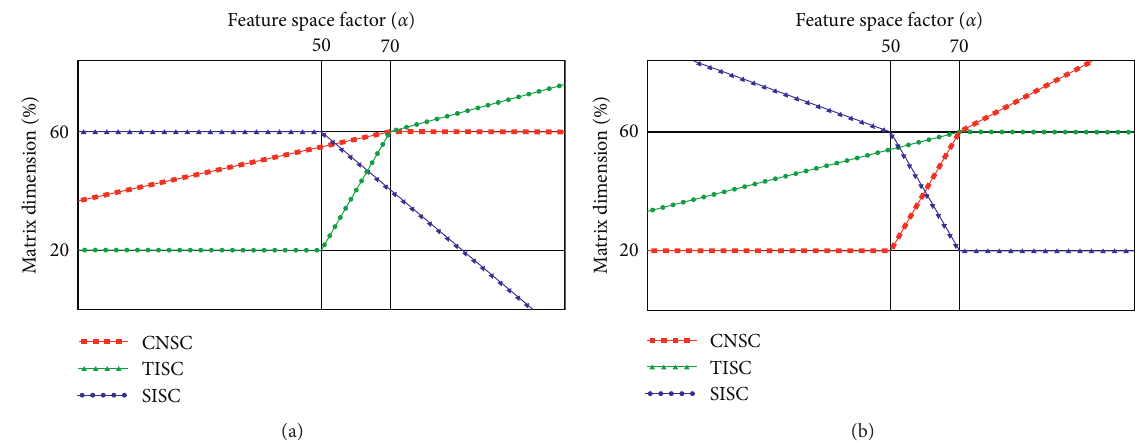
Figure 4: Relationship between matrix dimension and feature space factor of smart city’s construction model based on digital economy. CNSC, network connection of smart city; SISC, service interaction of smart city; TISC, technology infrastructure of smart